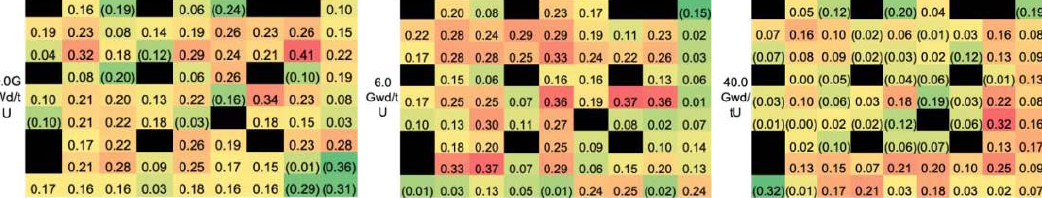
Figure 9. The pin power difference (%) for multi-annular fuel assembly (1/4) with burnup